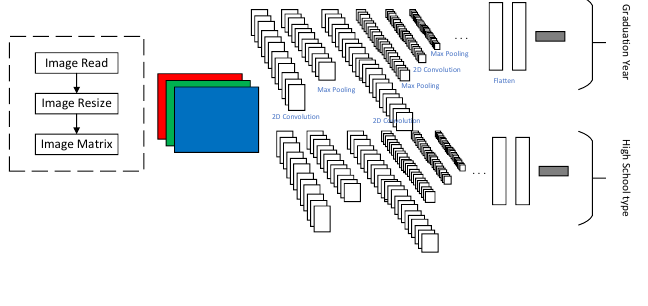
Fig. 3. Illustration of image classification model Table 1. Difference method between Guo Li and Na Li and Fangyi Zhu et al